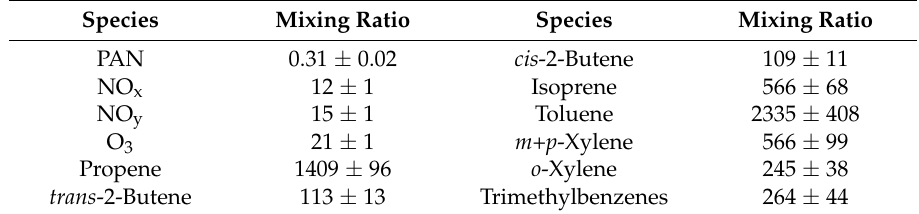
Table 3. The mixing ratios of PAN, its primary precursors, and trace gases at the backgarden site (median ± 95% confidence interval, unit: PAN, NO x , NO y , and O 3 are in ppbv, while non-methane hydrocarbons (NMHCs) are in